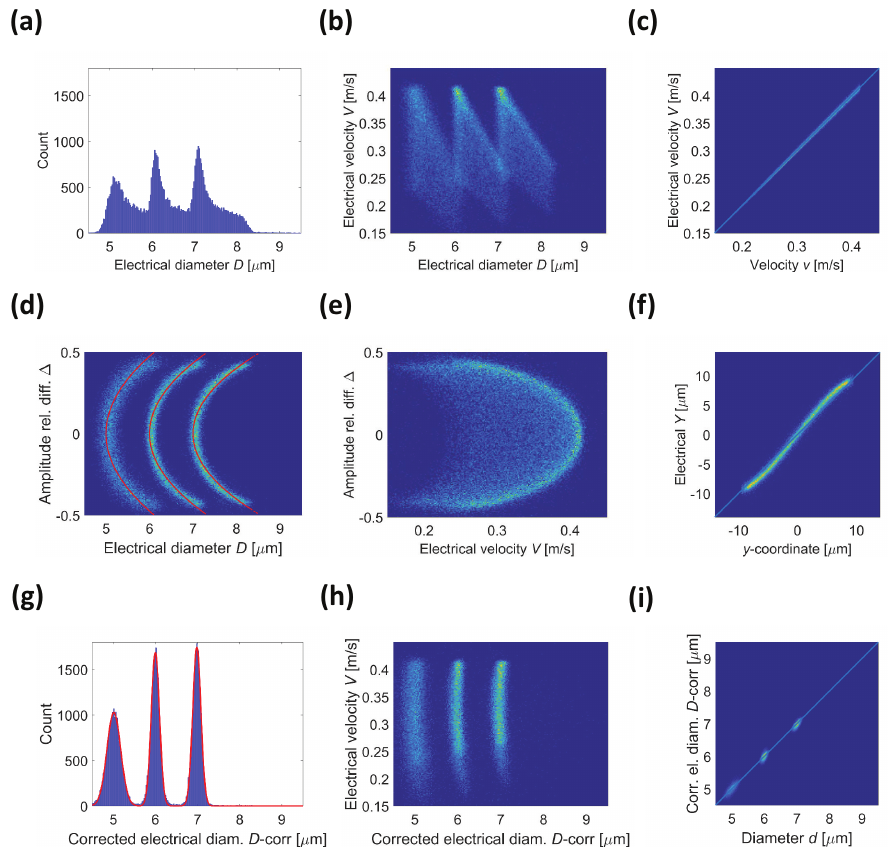
Figure 6. Facing electrode chip operated using the new wiring scheme. Virtual experiment relevant to a mixture of insulating beads with 5, 6, and 7 µ m diameter (data stream F new ). ( a ) Histogram of mix the electrical diameter D ; ( b ) Density plot of electrical velocity V vs. electrical diameter D ; ( c ) Density plot of electrical velocity V vs. velocity v ; ( d ) Density plot of pulse amplitude relative difference ∆ vs. electrical diameter D . The fitted parabolas D = a [ 1 + b ( ∆ − c ) 2 ] are shown as red lines (average values of parameters b and c , Table 1); ( e ) Density plot of pulse amplitude relative difference ∆ vs. electrical velocity V ; ( f ) Density plot of electrical Y vs. y -coordinate; ( g ) Histogram of the corrected electrical diameter D -corr. Fitting a Gaussian allows the coefficients of variation (CVs) to be calculated as follows: 3.3%, 1.6%, and 1.4%, for the 5, 6, and 7 µ m diameter beads, respectively; ( h ) Density plot of electrical velocity V vs. corrected electrical diameter D -corr; ( i ) Density plot of corrected electrical diameter D -corr vs. diameter d